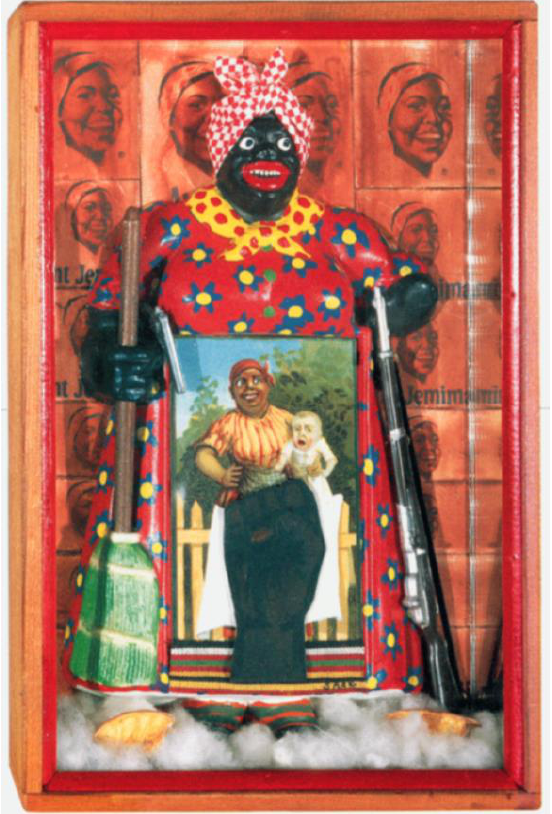
Figure 3. Betye Saar, “The Liberation of